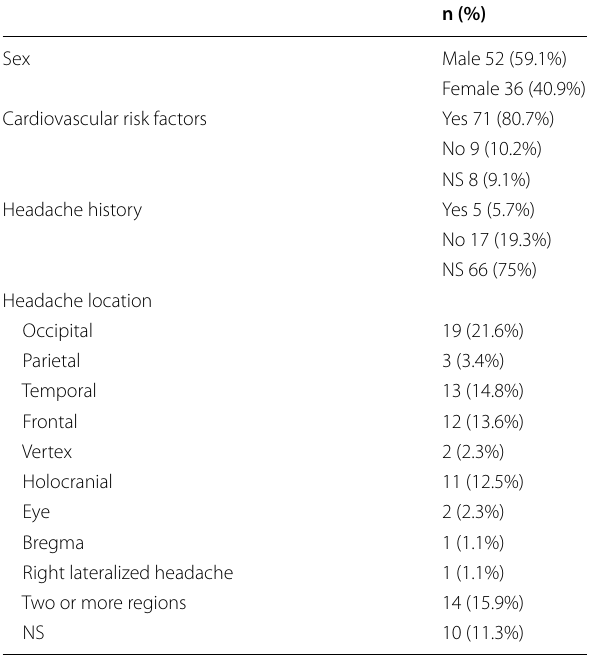
Table 3 Demographics and headache characteristics of patients with cardiac cephalalgia from our review ( n